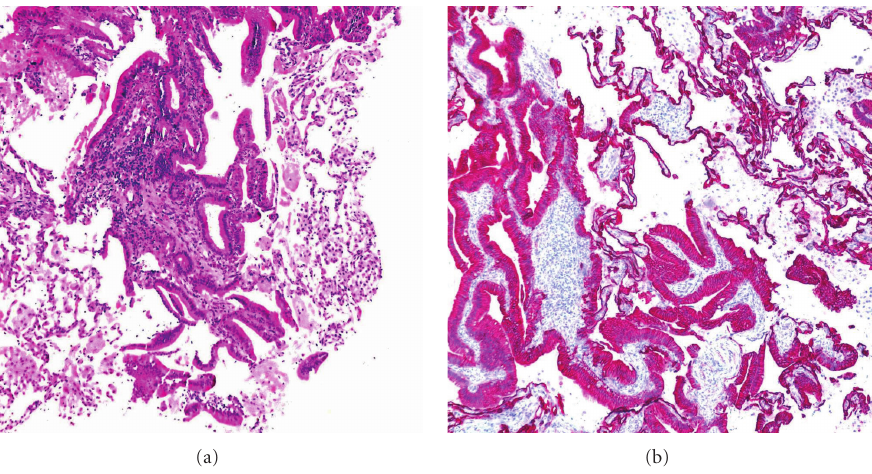
Figure 1: (a) H&E stain of a lung lesion showing carcinoma with lepidic growth. (b) Cytokeratin 7 immunohistochemical stain reveals strong reactivity on the lung